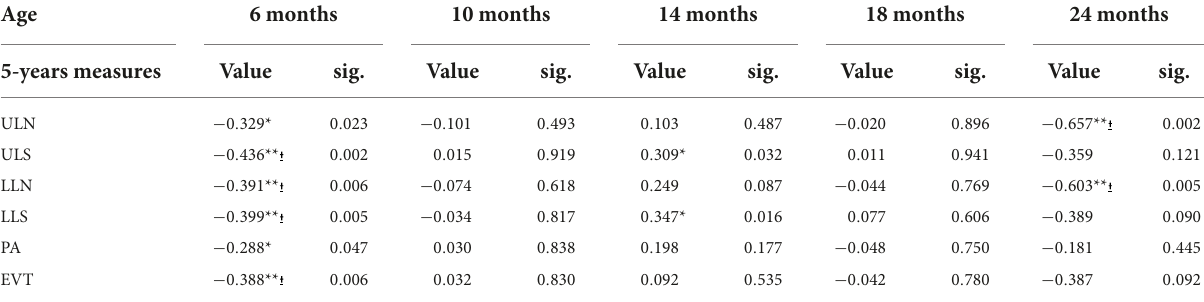
TABLE 5 Correlations between CS (child speech and speech-like vocalizations) at 6–24-months and reading-related measures at 5-years of age for the entire sample of 53